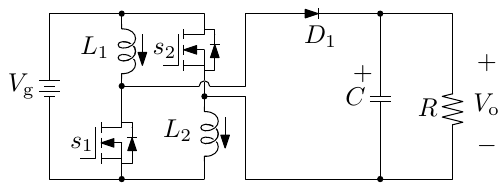
Figure 2. High step-up (HSU) power converter.